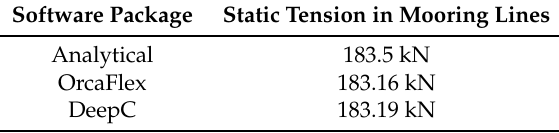
Table 9. Comparison of simulated static mooring line tension in OrcaFlex and DeepC. The analytical value is also listed.